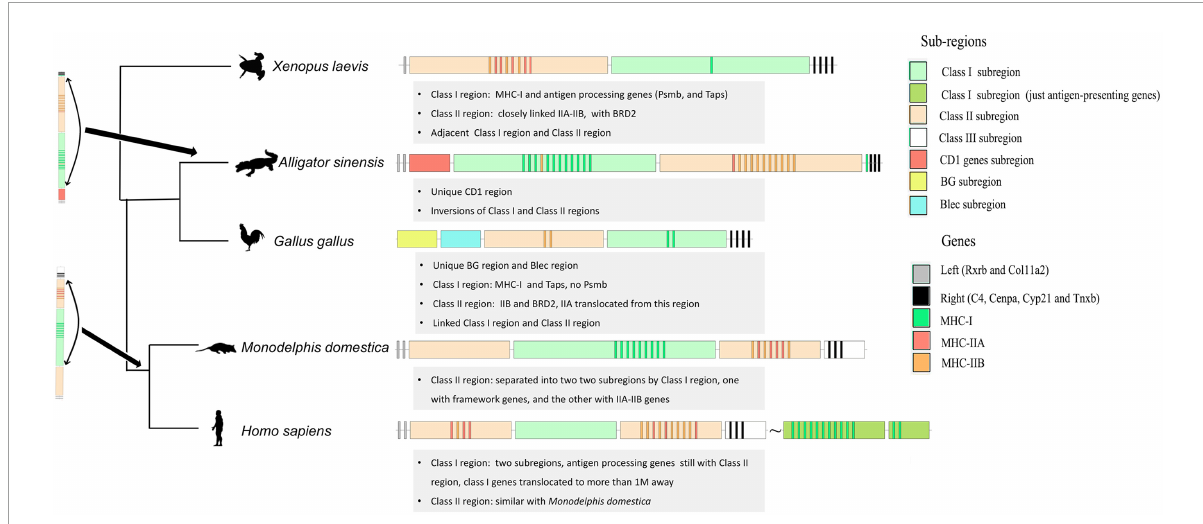
FIGURE4 Model of tetrapod MHC evolution. To distinguish the Homo-Class I subregion (with MHC-I genes) and the original location of antigen-processing genes, we labeled them with dark green (with MHC-I inside) and light green (the sub-region with antigen-processing